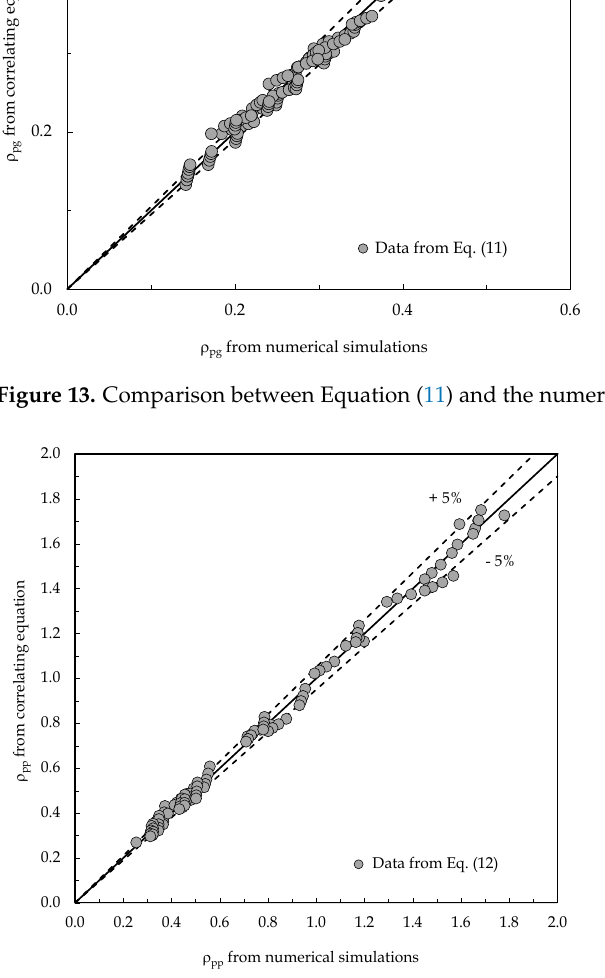
Figure 14. Comparison between Equation (12) and the numerical data obtained for ρ pp